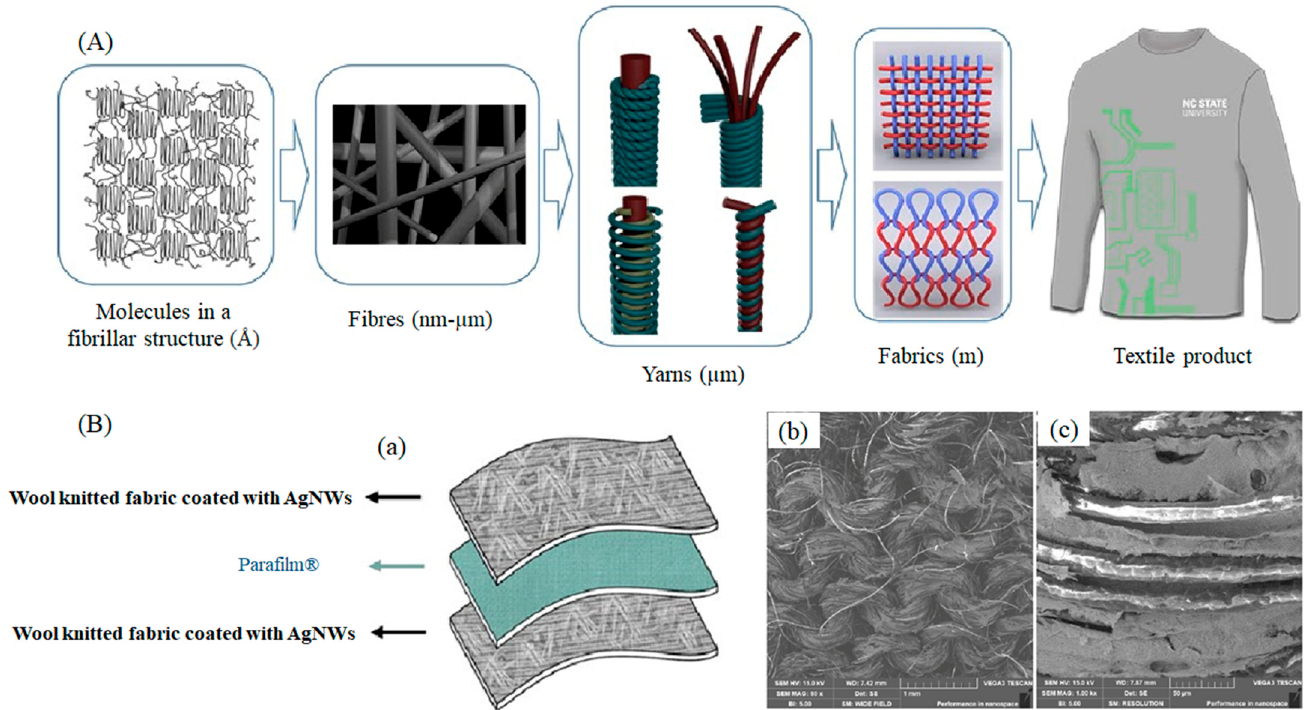
Figure 3. ( A ). Electrically conductive coatings for fibre-based e-textiles; ( B ). ( a ) Silver nanowire coated knitted wool fabrics for wearable electronic applications, SEM images of conductive knitting fabric after coating and washing with distilled water under ( b ) 60× and ( c ) 1000× magnifications [28,46]. water under ( b ) 60 × and ( c ) 1000 × magnifications